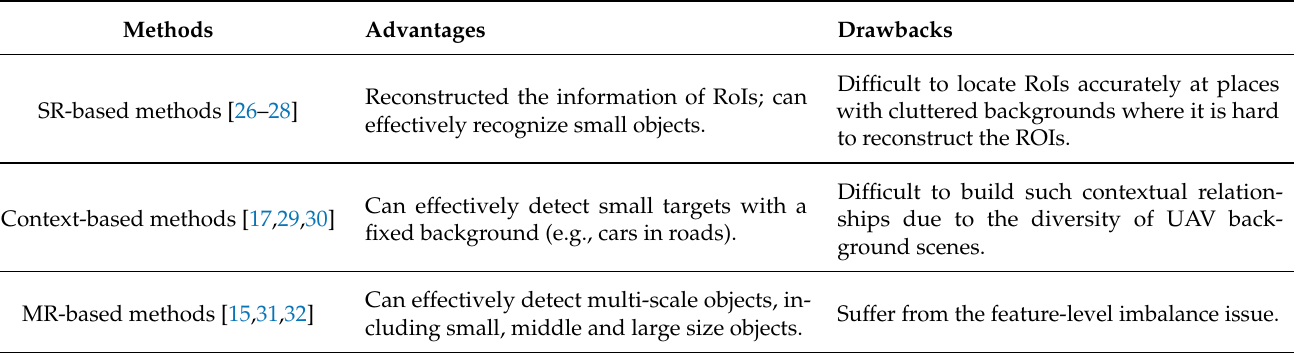
Table 1. Summary of the advantages and drawbacks of object detectors for drone-captured